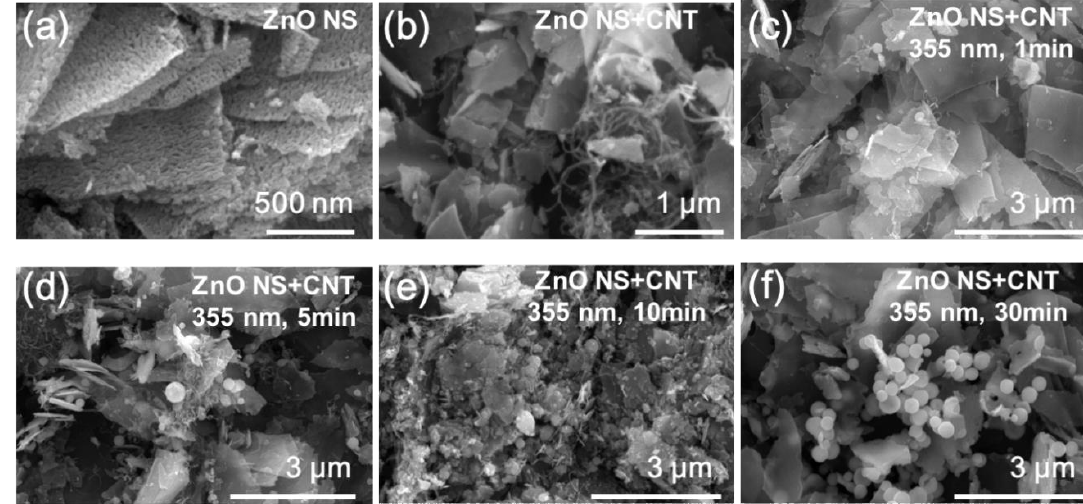
Figure 2 . Scanning electron microscopy images for as-prepared ( a ) ZnO NS, ( b ) ZnO NS-CNT, ( c ) ZnO NS-CNT (355 nm, 1 min), ( d ) ZnO NS-CNT (355 nm, 5 min), ( e ) ZnO NS-CNT (355 nm, 10 min), and ( f ) ZnO NS-CNT (355 nm, 30 min).